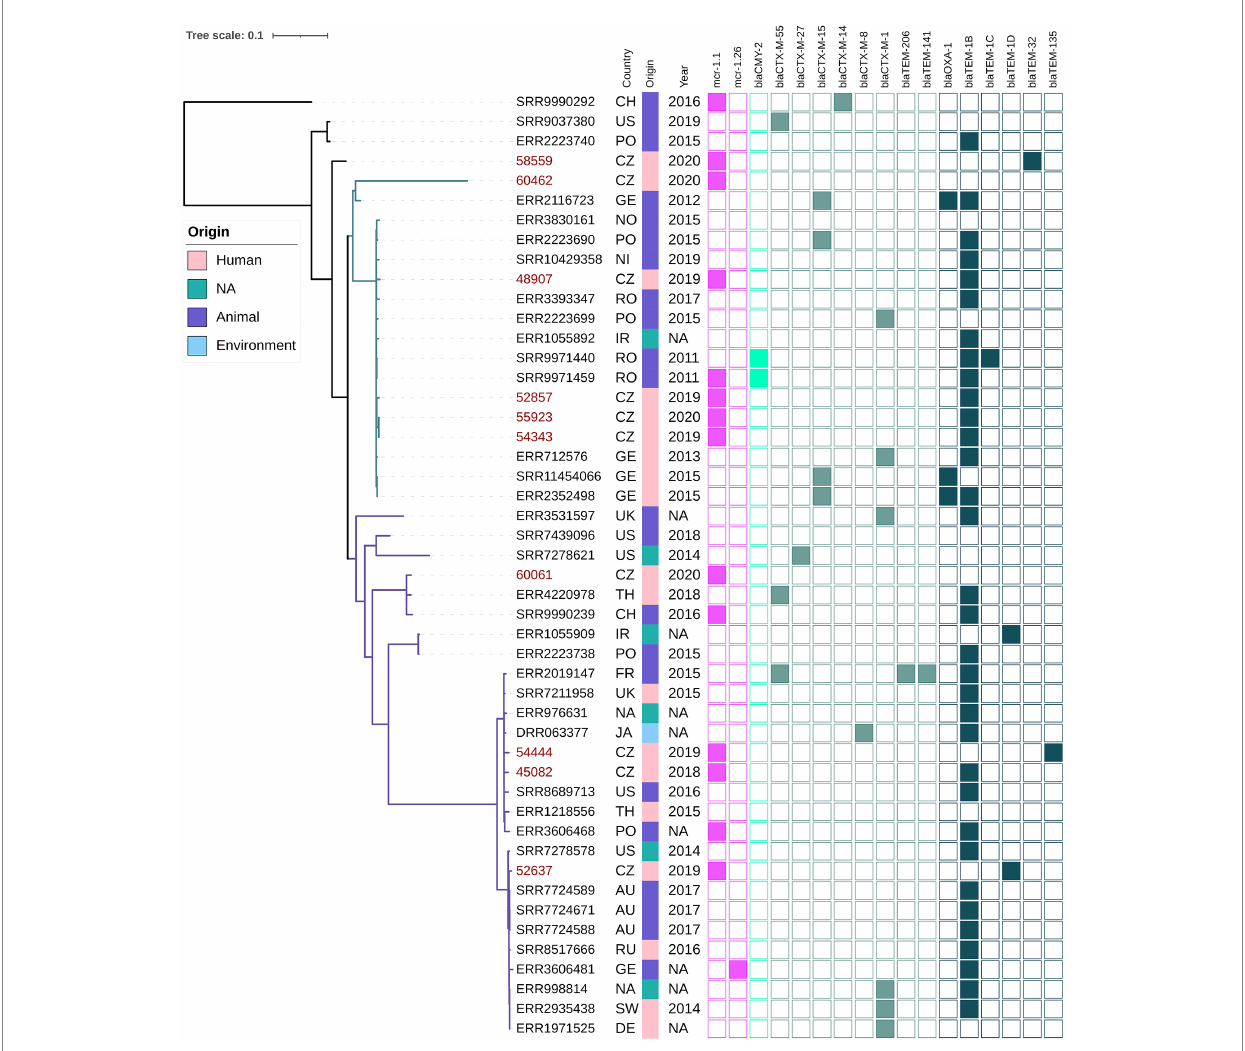
FIGURE 3 Phylogenetic tree of Czech clinical E. coli ST744 isolates with selected sequences from global collection. The red labels indicate isolates coming from this study. The metadata specifies country of origin (Country): China (CH), The United States (US), Poland (PO), Czech Republic (CZ), Germany (GE), Norway (NO), Nigeria (NI), Romania (RO), United Kingdom (UK), Thailand (TH), Ireland (IR), France (FR), Ukraine (UK), Australia (AU), Russia (RU), Switzerland (SW), not available (NA), the source of origin (Source) and the year of isolation (Year). The colour squares represent presence (full square) or absence (empty square) or respective antibiotic resistance genes divided to genes encoding resistance to colistin (pink), carbapenemases (blue) and other beta-lactamases (turquoise, see legend Figure